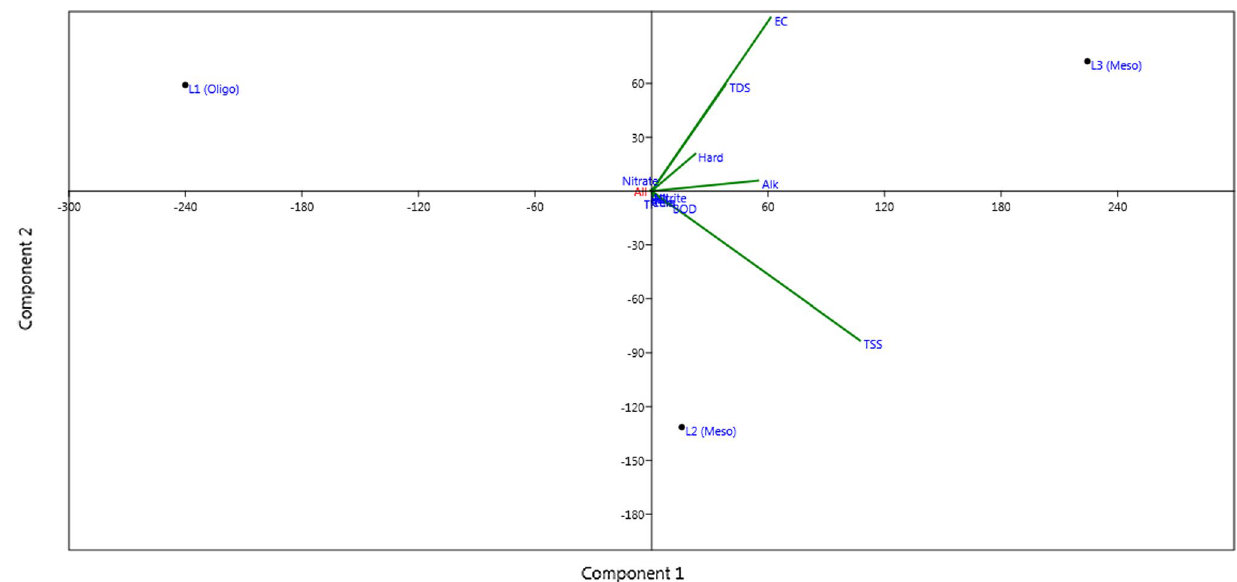
Fig. 2 Principal Component Analysis (PCA) of water from the selected lakes (i.e., Lake 1 = L1 (Oligo), Lake 2 = L2 (Meso) and Lake 3 = L3(Meso))